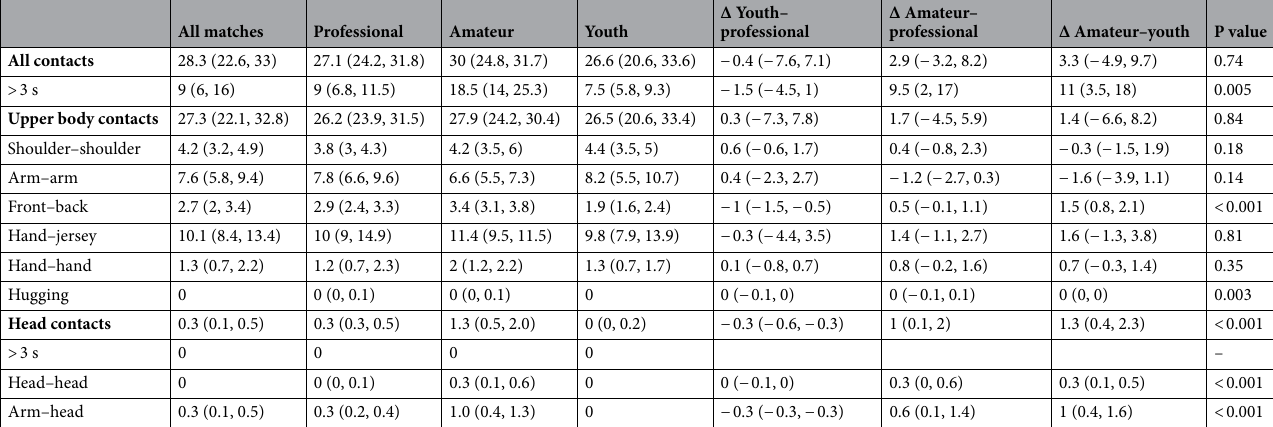
Table 2. Between-player contacts representing potential risk situations associated with the transmission of respiratory diseases. Data for the different playing levels are presented as frequency per player-hour, as absolute numbers (contacts of more than 3 s duration) and as median with interquartile range. Differences between playing levels are displayed as median differences with 95% confidence intervals. P values from Kruskal–Wallis test.